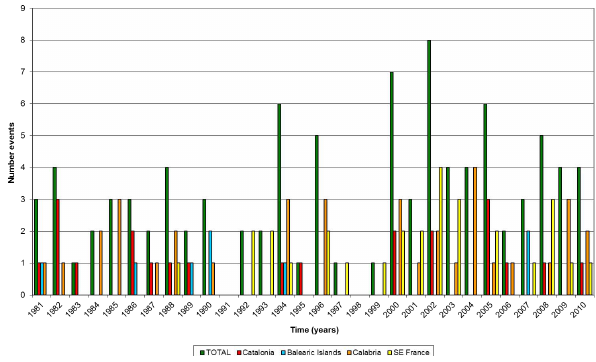
Fig. 4. Monthly distribution of catastrophic floods (1981–2010).